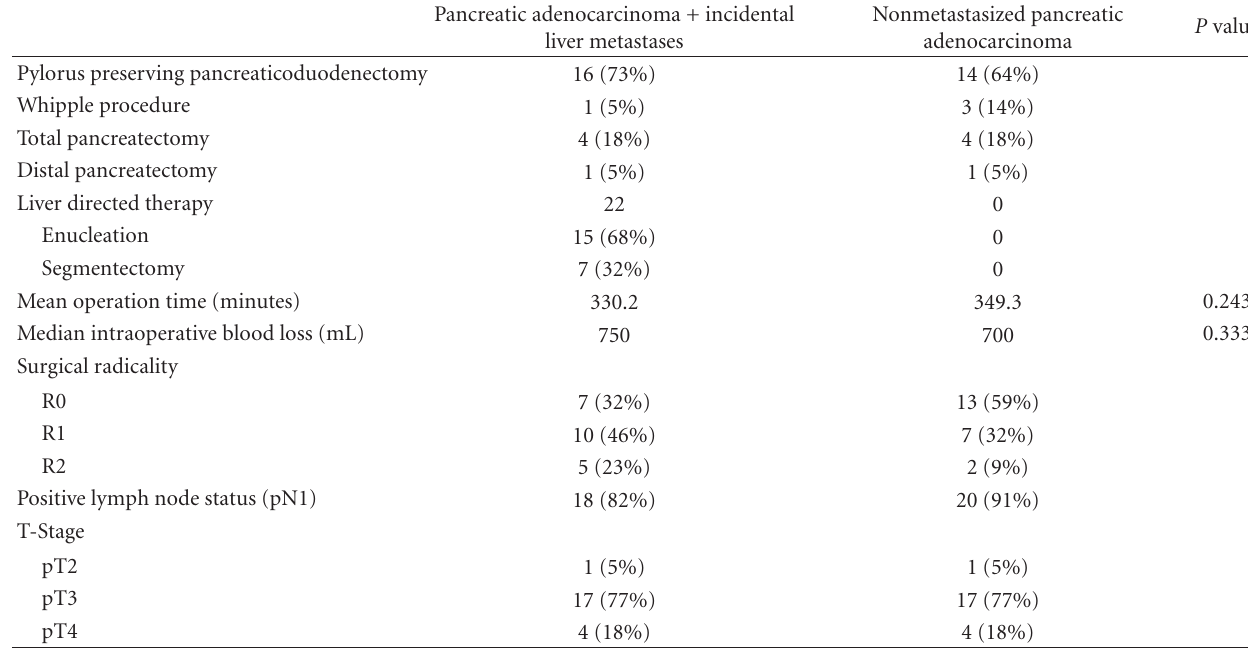
Table 2: Operative course and histopathological findings.